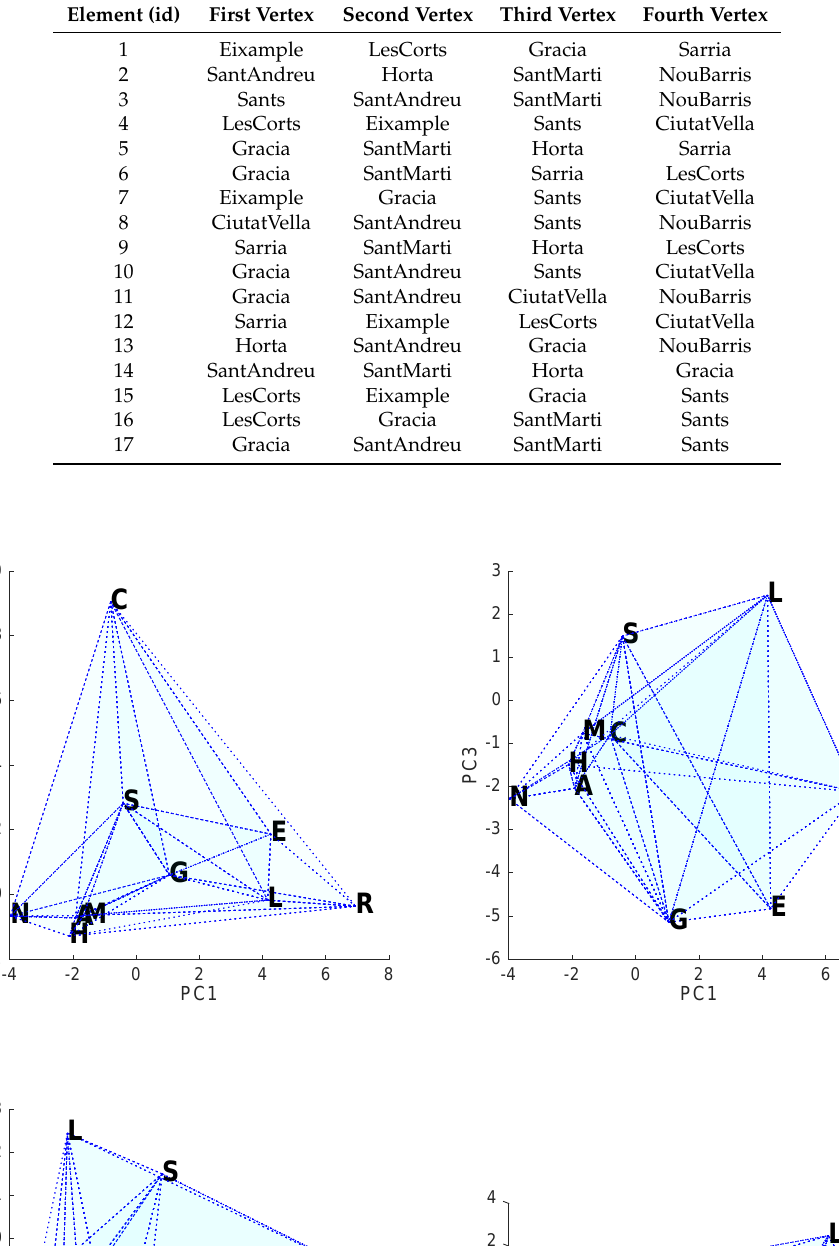
Table 1. Tetrahedral elements derived from the Delaunay Triangulation of the set of points.